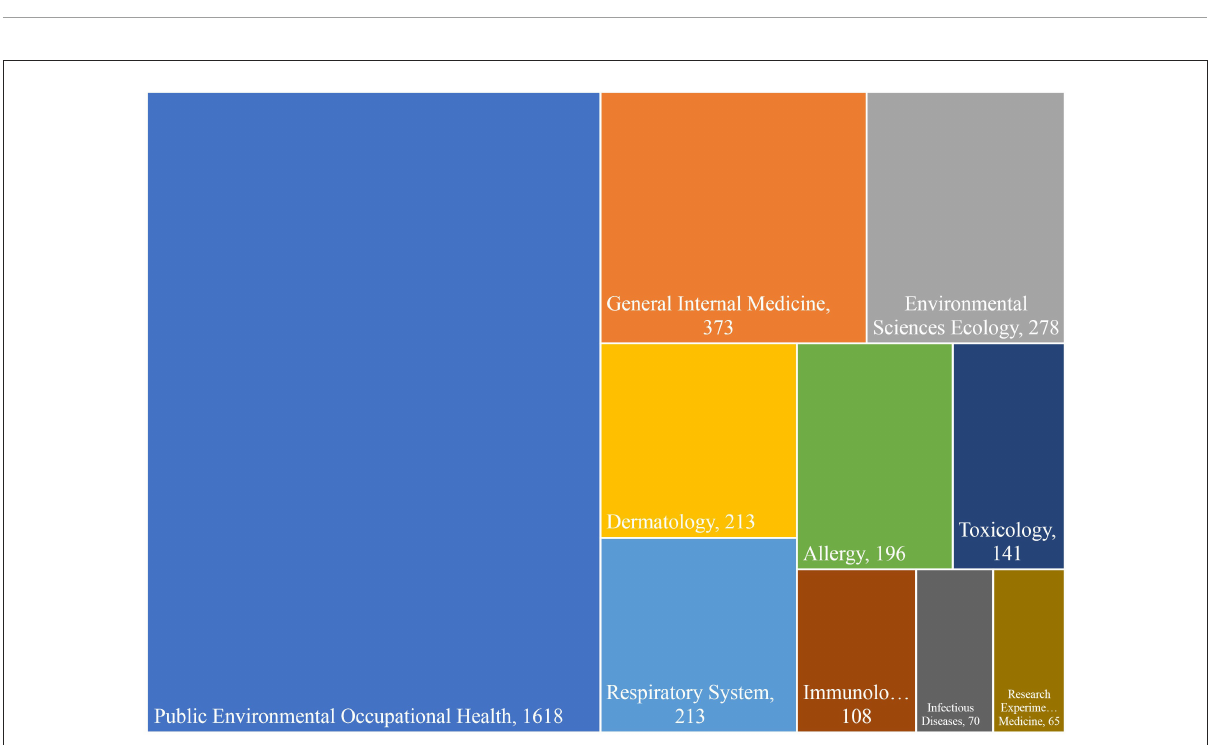
FIGURE2 Top 10 specialized areas of publishing articles on occupational diseases over the past 46